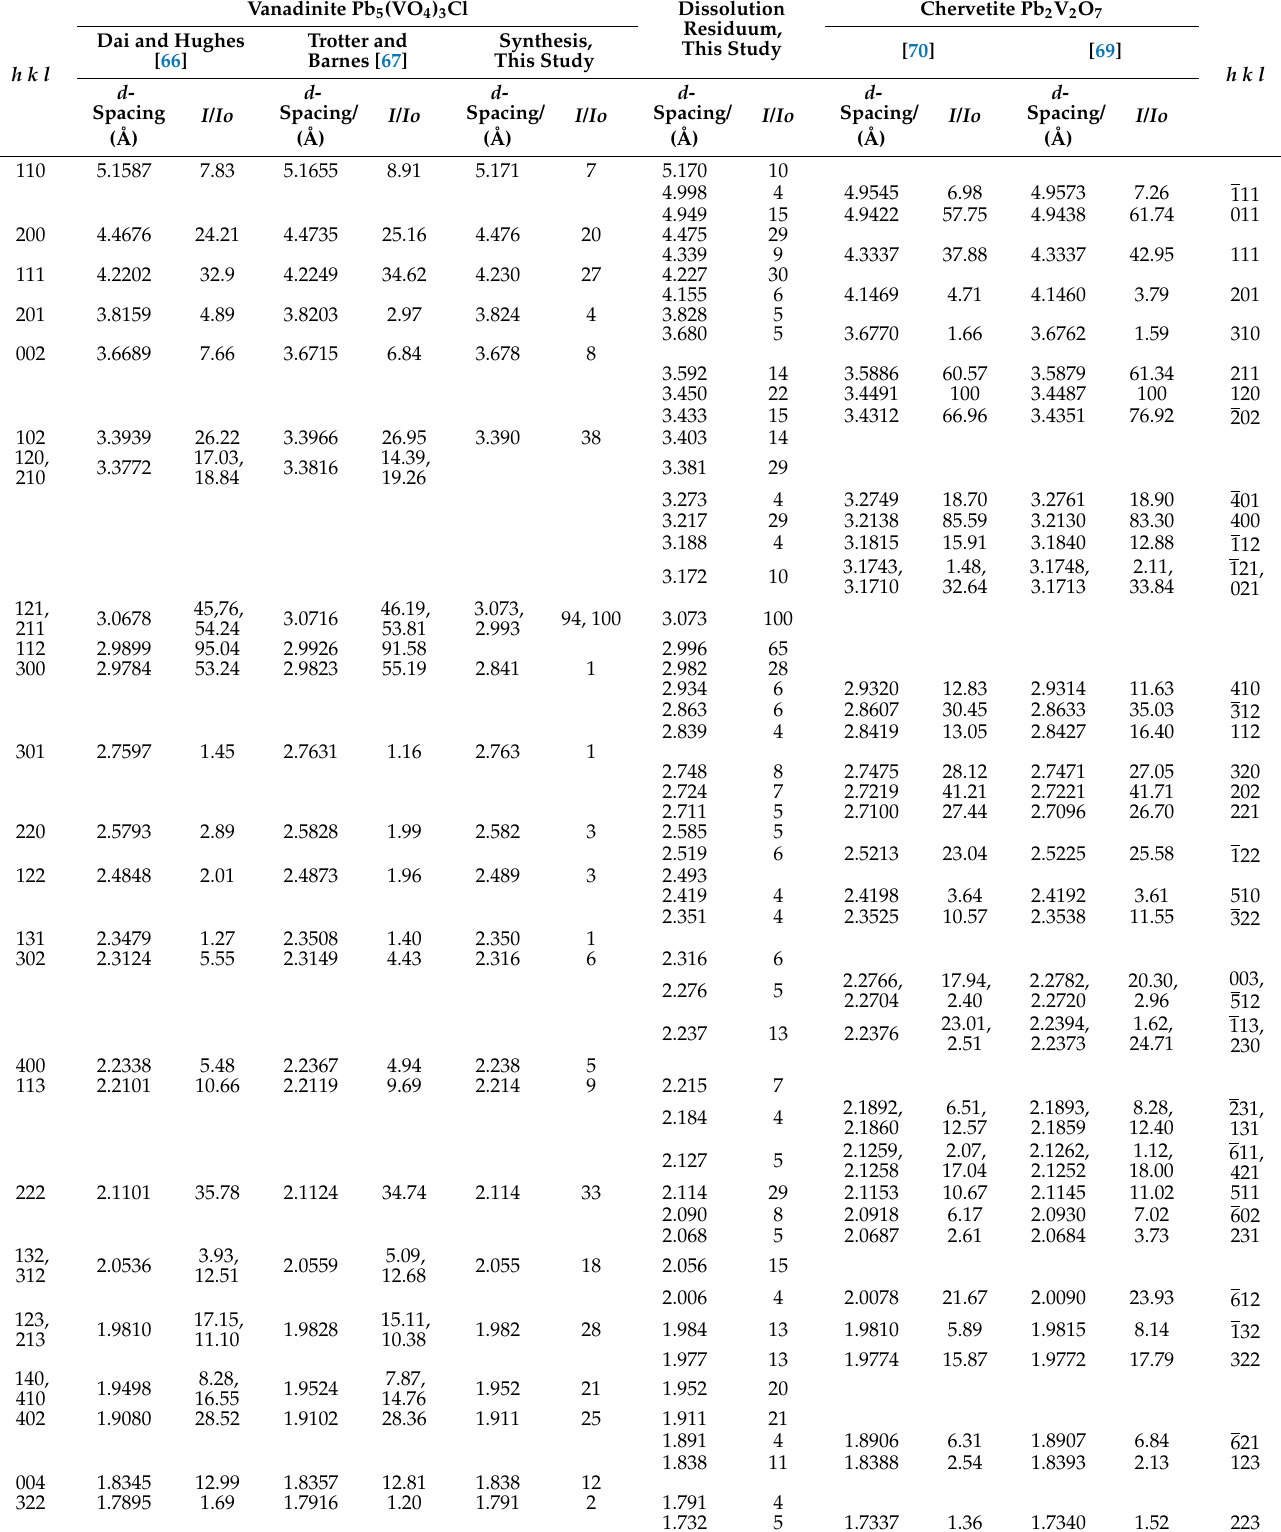
Table A1. Powder X-ray diffraction peaks from synthetic Pb 5 (VO 4 ) 3 Cl used in this study compared with data reported in the literature: Miller indices h k l , distance d between adjacent ( h k l ) planes and the peak intensity ratio I/Io